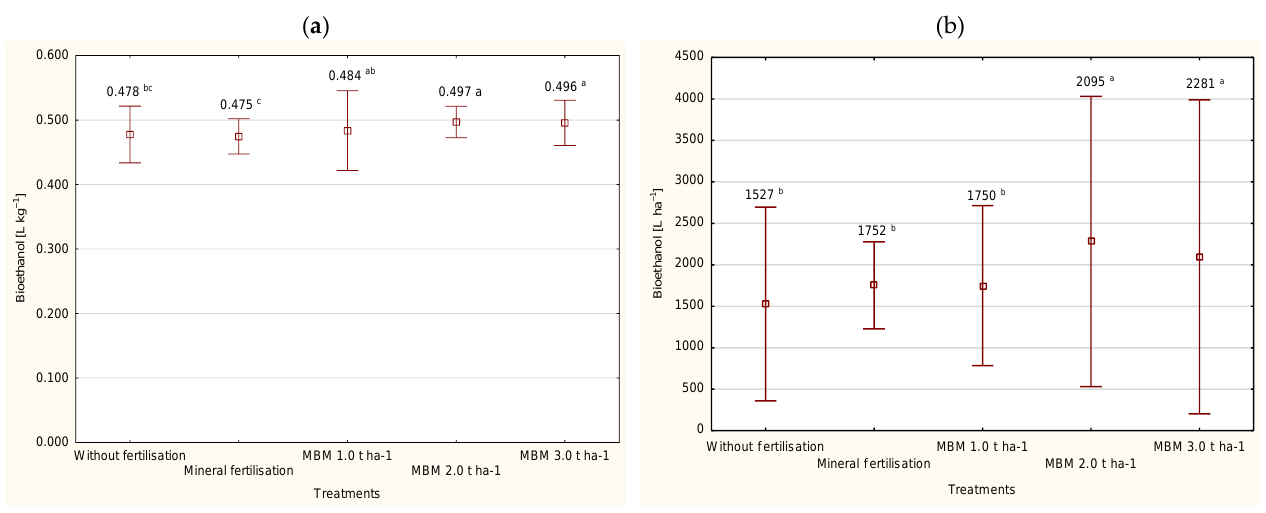
Figure 6. Volume of bioethanol (mean value and standard deviation) obtained from corn grain ( a ), and bioethanol yield from a hectare ( b ), considering fertilization treatment. MBM — Meat and Bone Meal. a,b,c — Values followed by the same letters do not differ significantly in Tukey’s (HSD) test ( p < 0.05).